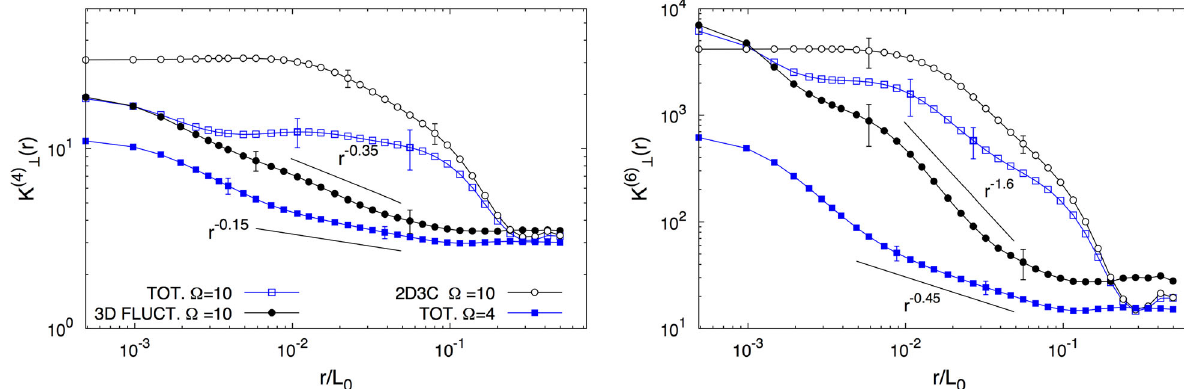
4 Þ r Þ derived from the Eulerian structure functions transverse to the rotation FIG. 7. Left: Log-log plot of the fourth-order flatness K ð ⊥ ð axis, for data with N ¼ 2048 . Data from DNS with large rotation rate, in the presence of an inverse cascade ( Ω ¼ 10 , Ro ¼ 0 . 25 ): full field u (empty squares); 2D3C u 2 component (empty circles); fluctuating 3D component u 0 (filled circles). Data from DNS with the D direct cascade only, and no-columnar vortices ( Ω ¼ 4 , Ro ¼ 0 . 76 ): full field u ð x; y; z Þ (filled squares). We also superpose the power - law prediction ∝ r − 0 . 15 obtained from independent measurements of isotropic turbulence without rotation and the best fit for the power 6 Þ r Þ (same symbols). law measured with intense rotation in the present data ∝ r − 0 . 35 . Right: The same for the sixth-order flatness K ð ⊥ ð Error bars are estimated from different velocity snapshots and shown for a representative subset of